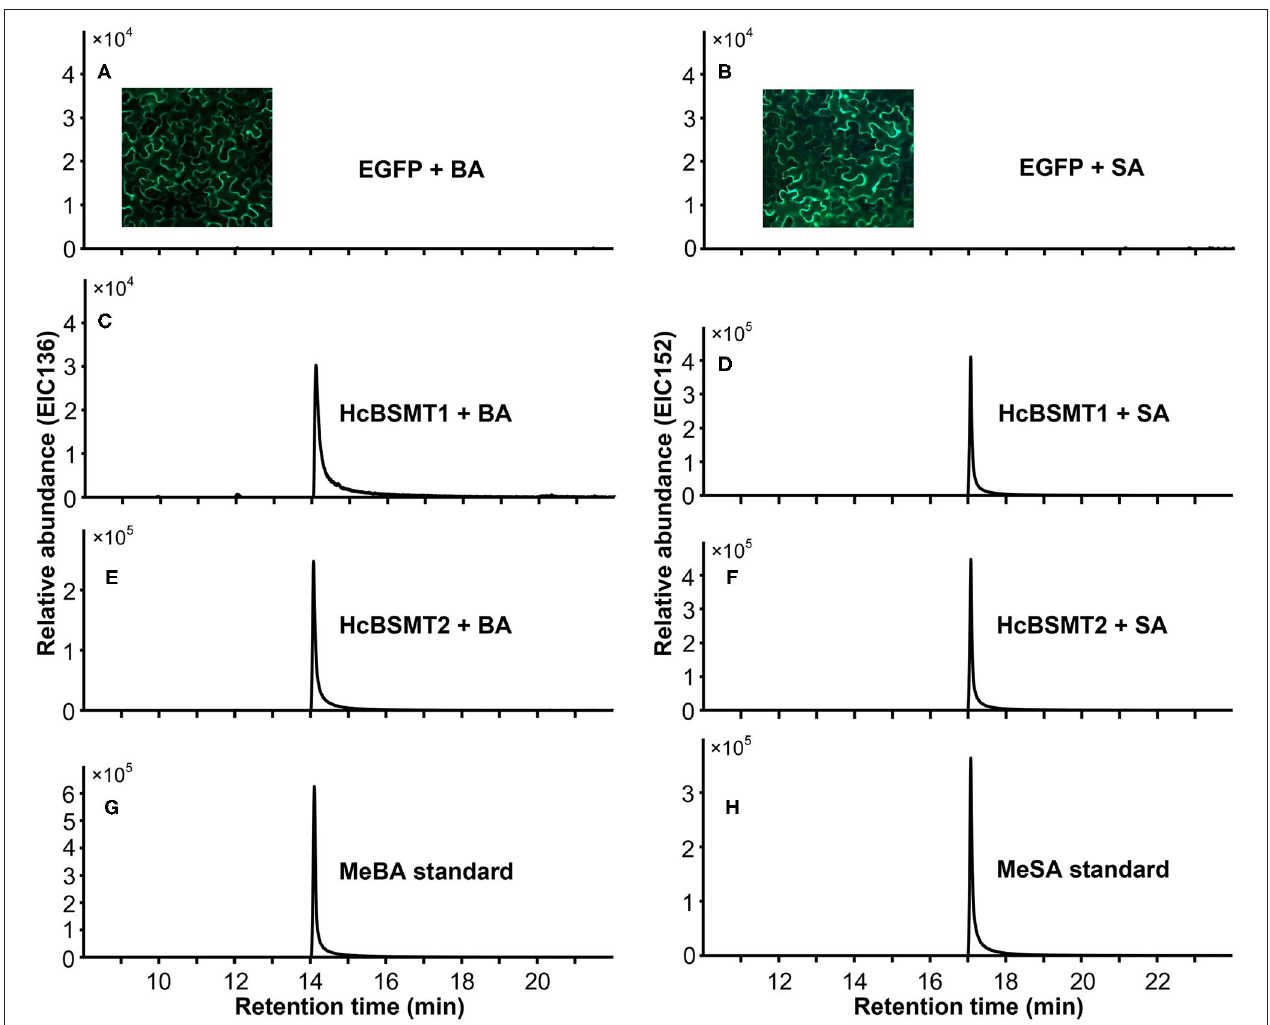
FIGURE 4 | Characterization of HcBSMTs in planta . EGFP (A,B) , HcBSMT1 (C,D) , and HcBSMT2 (E,F) were transiently expressed in N. benthamiana leaves by Agrobacterium -mediated infiltration. The substrate benzoic acid (BA) or salicylic acid (SA) was infiltrated into tobacco leaves prior to headspace collection and GC-MS analysis. EIC136 represent extracted ion chromatograms (EIC) at a mass/charge ratio (m/z) of 136 (molecular ion of MeBA). EIC152 represent EIC at m/z of 152 (molecular ion of MeSA). Enhanced green fluorescent protein (EGFP) was used as a negative control. Insets in panels (A,B) showed the EGFP fluorescence of tobacco leaves harboring transiently expressed EGFP protein, indicating high transformation efficiency. (G) EIC of methyl benzoate (MeBA) authentic standard. (H) EIC of methyl salicylate (MeSA) authentic